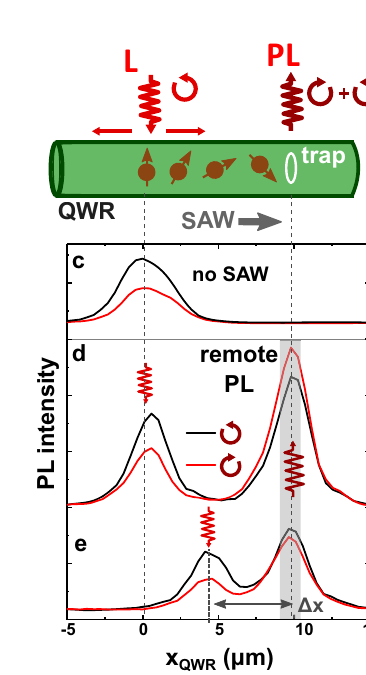
Fig.2|Opticallydetectedtransportofspinsinplanarquantumwires.a Sidewall quantumwires(QWRs)formedbytheepitaxialovergrowthofaquantumwell(QW) on a GaAs (001) substrate structured with shallow ridges 30 . The QWRsare 200nm- wideandhavealengthde fi nedbyphotolithography,whichistypicallyseveraltens of microns long. Photoexcited carriers are transported along the QWR by surface acoustic waves (SAWs) generated by interdigital acoustic transducers (IDTs). b Photoluminescence (PL) spectra recorded outside (red) and on (black) a ridge